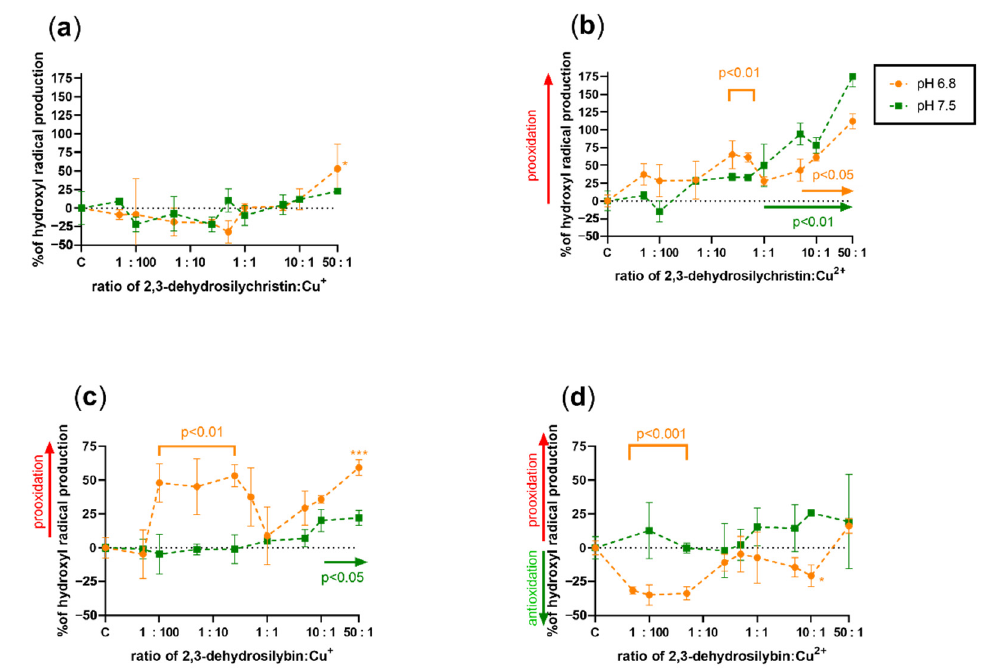
Figure 8. Effect of 2,3-dehydrosilychristin and 2,3-dehydrosilybin on the copper-based Fenton chemistry at pH 6.8 and 7.5: ( a ) 2,3-dehydrosilychristin + Cu + ; ( b ) 2,3-dehydrosilychristin + Cu 2+ ; ( c ) 2,3-dehydrosilybin + Cu + ; ( d ) 2,3-dehydrosilybin + Cu 2+ . Statistical significance vs. the control (C: positive blank—the Fenton reaction with the solvent alone) is shown directly in the figure with exception of isolated points (* for p < 0.05 and *** p < 0.001).